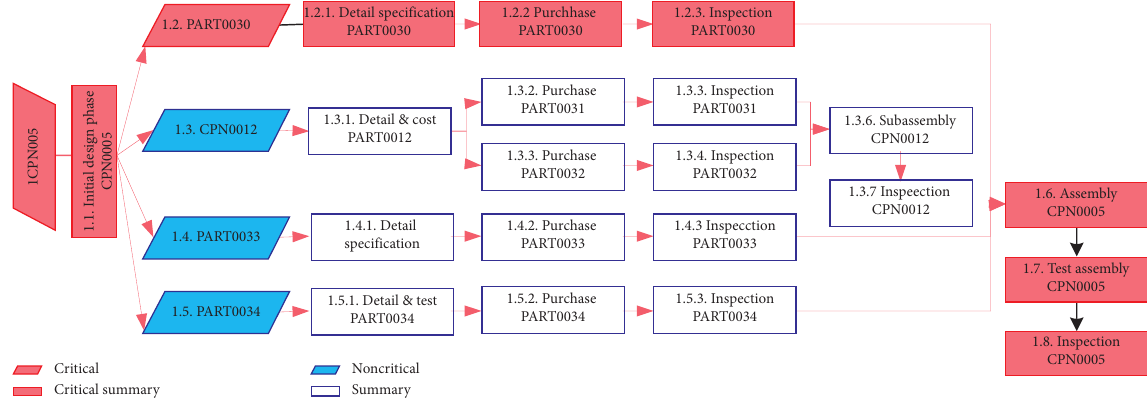
Figure 4: Manufacturing process. Table 3: Manufacturing process and required resources.